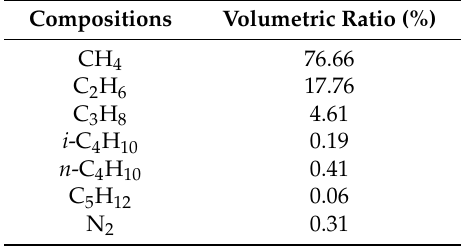
Table 2. Natural gas composition used in engine test.